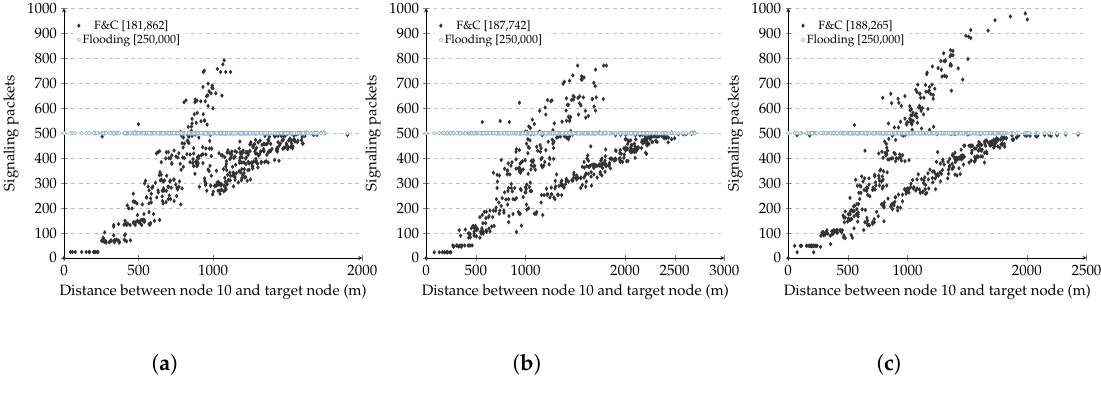
Figure 12. F&C under non-ideal conditions. ( a ) Irregular network shape; ( b ) Mobility: After nodes moved during 1 min; ( c ) Mobility: After nodes moved during 10